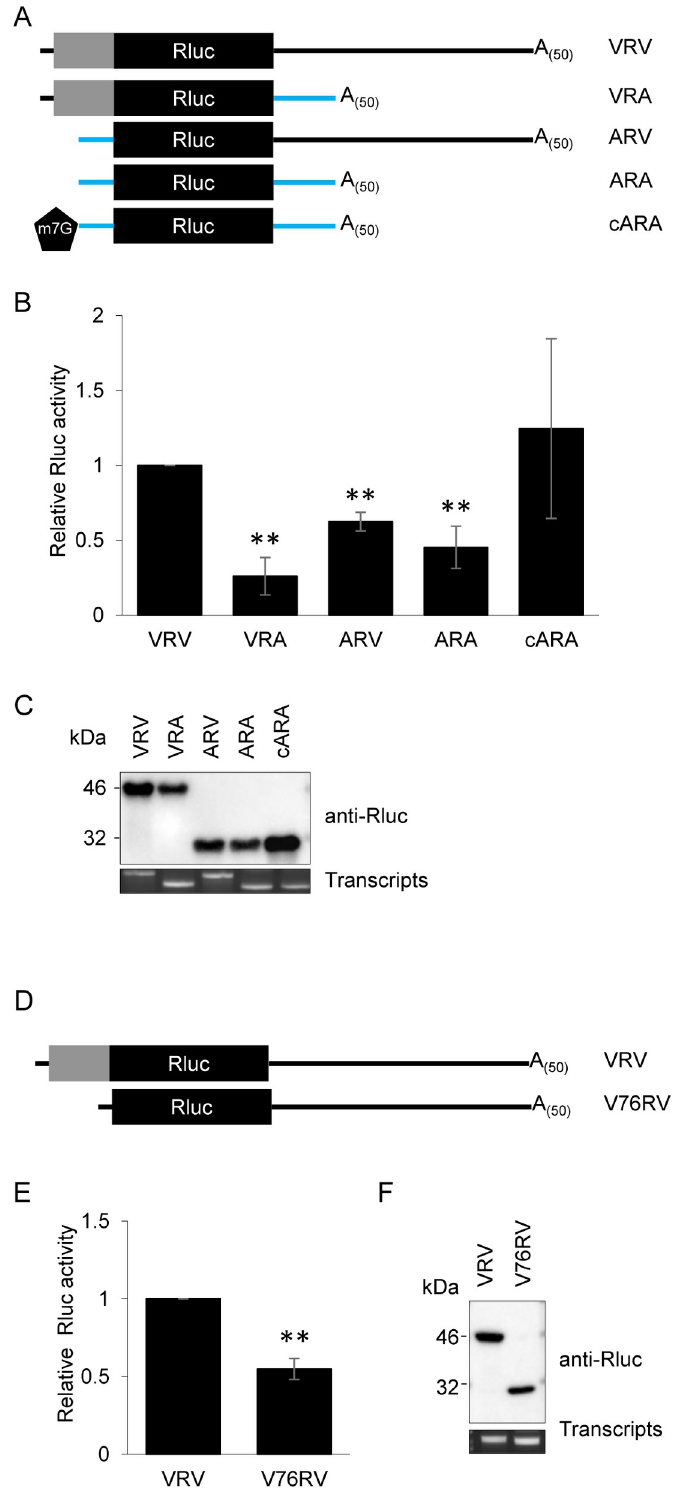
Fig 4. The ToRSV 5’ region and 3’ UTR are both required for efficient translation from reporter transcripts. (A) Schematic representation of VRV and derivative transcripts. In the derivative transcripts, the viral 5’ region and/or 3’ UTR (black lines) are replaced by the actin 5’ and/or 3’ UTR (blue lines). Grey rectangles represent the fusion of